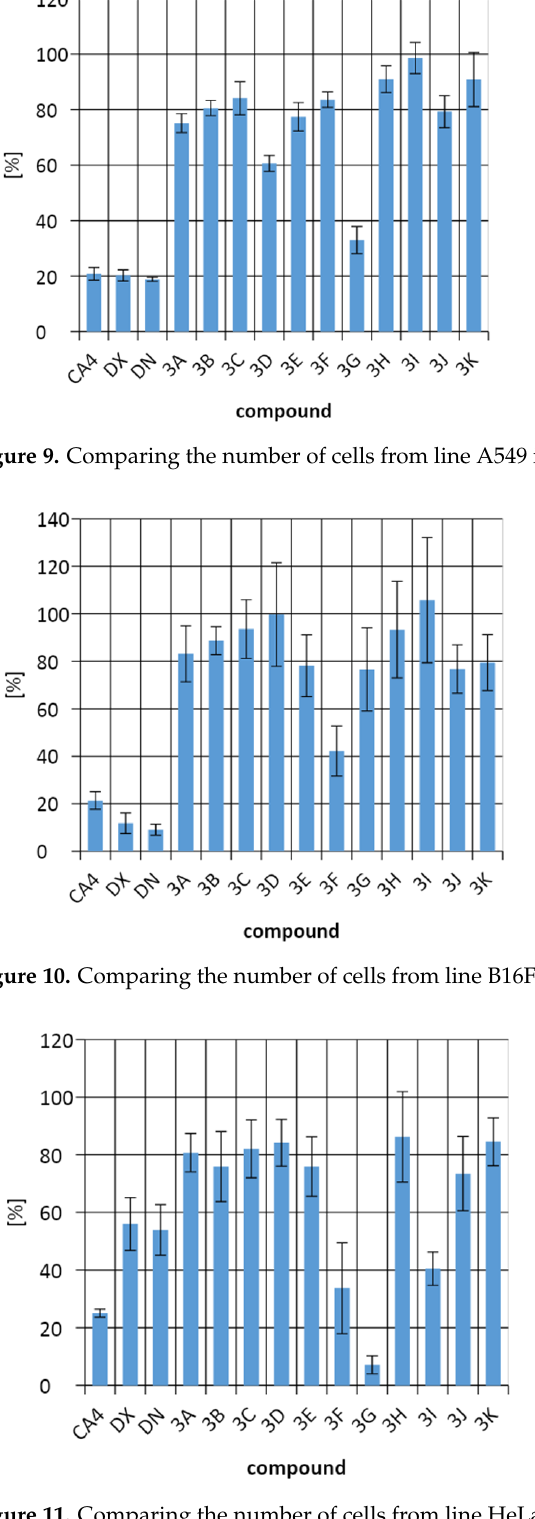
Figure 11. Comparing the number of cells from line HeLa in relation to the control culture. 2.4. Binding to Albumin The chemical compounds described in this study can bind very well with albumin. The free fraction for 2-substituted indan-1,3-dione derivatives ranges from 3 to 17%, which suggests that these compounds will exhibit prolonged action after administration. These combinations in the body will probably be slowly released from the complex with albumin, which will lead to a relatively low concentration (Figure 12).